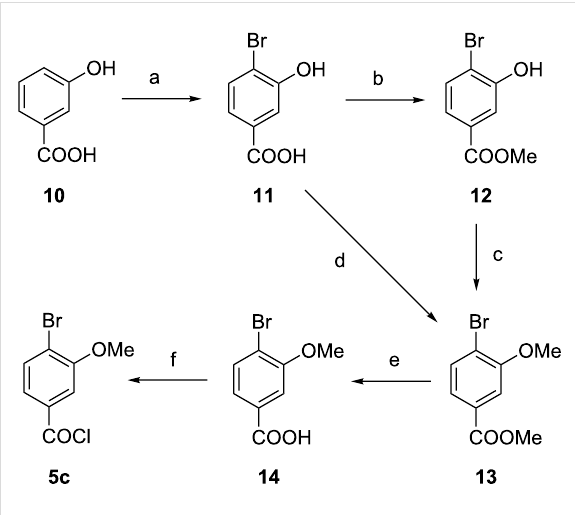
Figure 6: Syntheses of 4-bromo-3-methoxybenzoyl chloride ( 5c ). Conditions: a) Br 2 , EtOH/HOAc, 30 min, room temperature, 52%, b) MeOH/H 2 SO 4 , MeOH, 16 h, reflux, 94%, c) Me 2 SO 4 , K 2 CO 3 , acetone, 3 h, reflux, quant., d) MeI, K 2 CO 3 , DMF, 16 h, room tempera- ture, 83%, e) NaOH, H 2 O, MeOH, 6 h, room temperature, 66%, f) SOCl 2 , DMF (cat.), 2 h, reflux, not isolated.